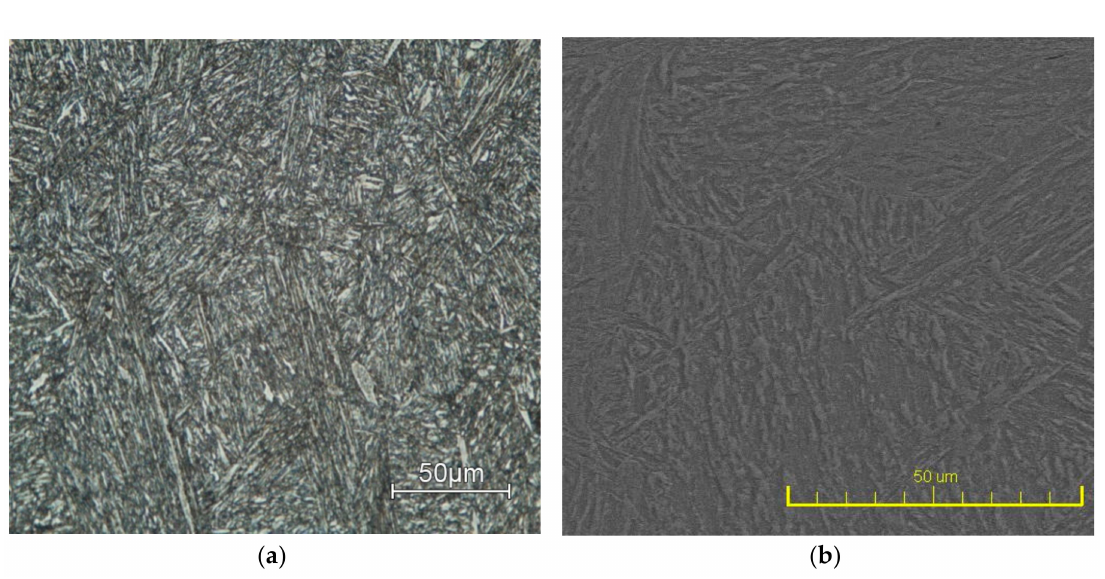
Figure 1. Microstructure of base material AISI 4340, etching by 3% Nital: ( a ) LOM; ( b )